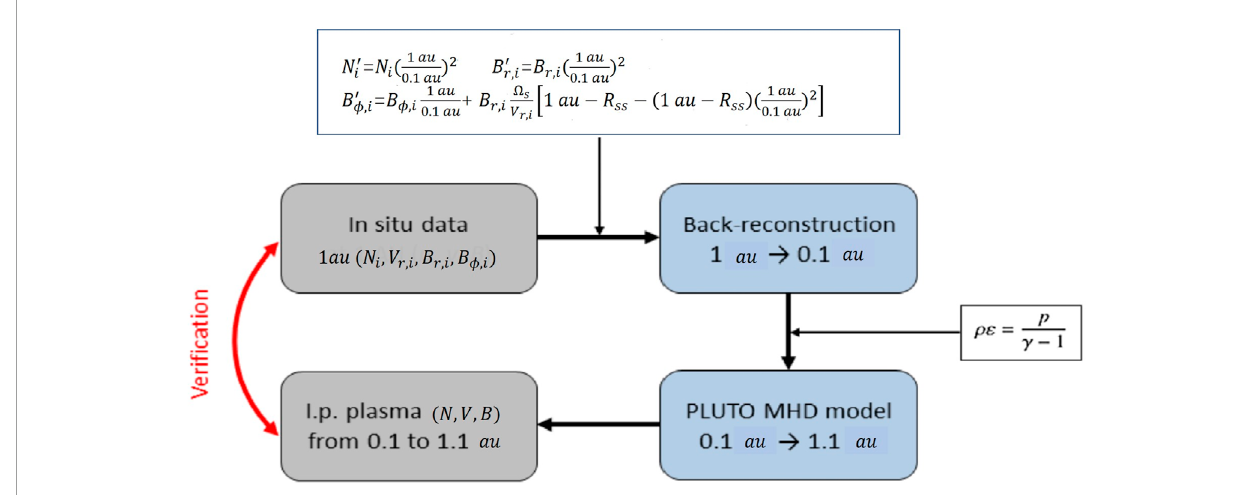
FIGURE 5 Schematic of the steps involved in RIMAP for the reconstruction of heliospheric plasma conditions starting from in situ measurements (Biondo et al.,